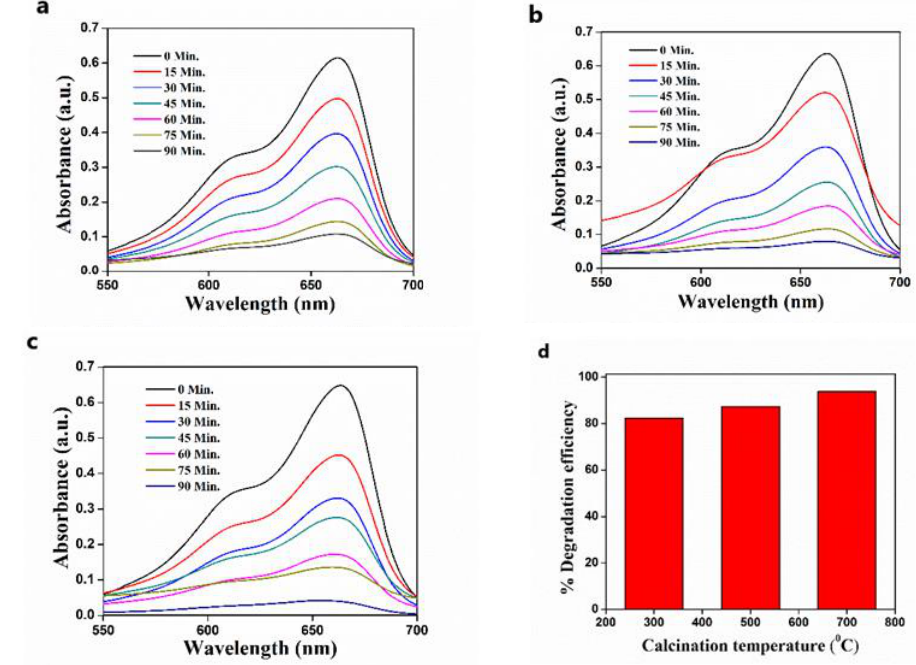
Figure 11. The photocatalytic degradation of MB after treatment with ZnO calcined at ( a ) 300 ◦ C; ( b ) 500 ◦ C; ( c ) 700 ◦ C; ( d ) the effect of calcination temperature of ZnO on MB photodegradation.